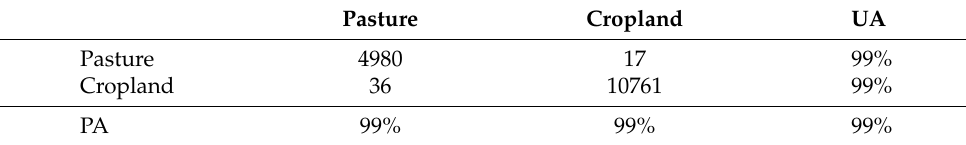
Table 4. Confusion matrix—original Dataset.